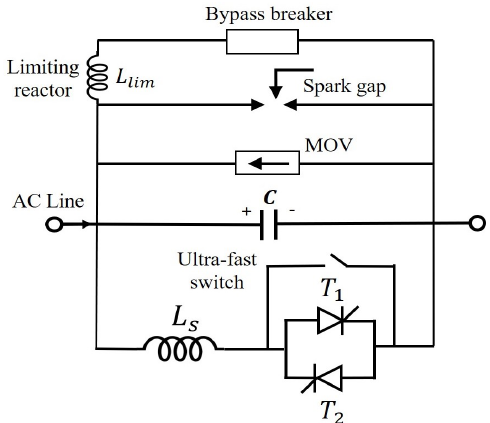
Figure 9. TCSC Protection equipment [4], based on Reference